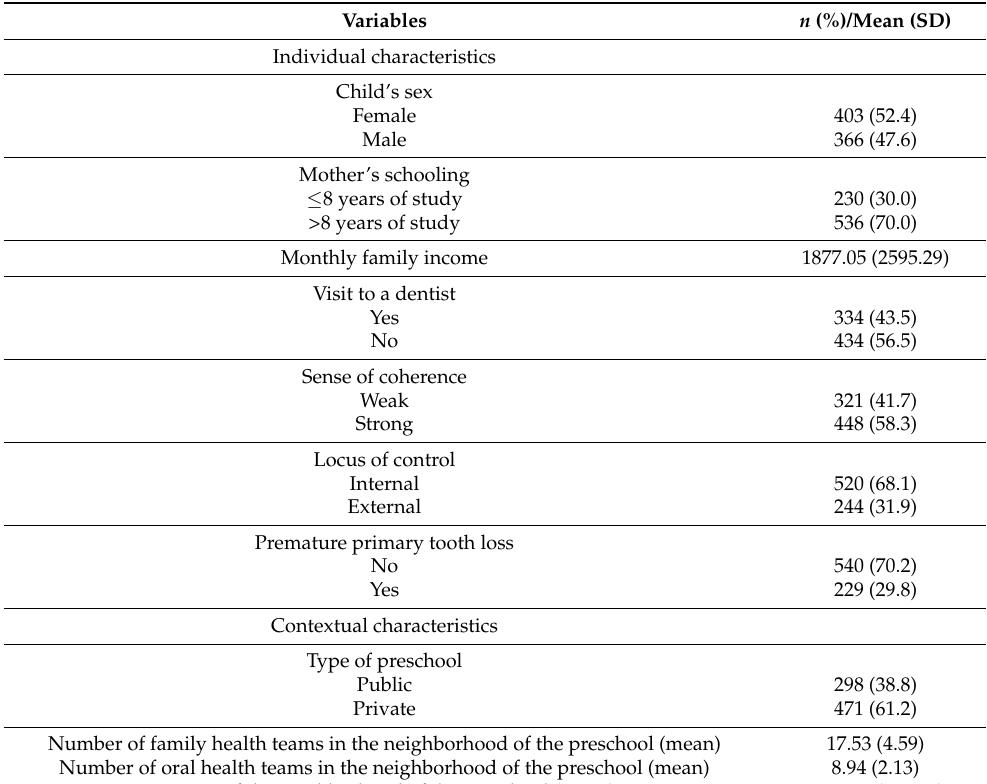
Table 1. Individual and contextual characteristics of the